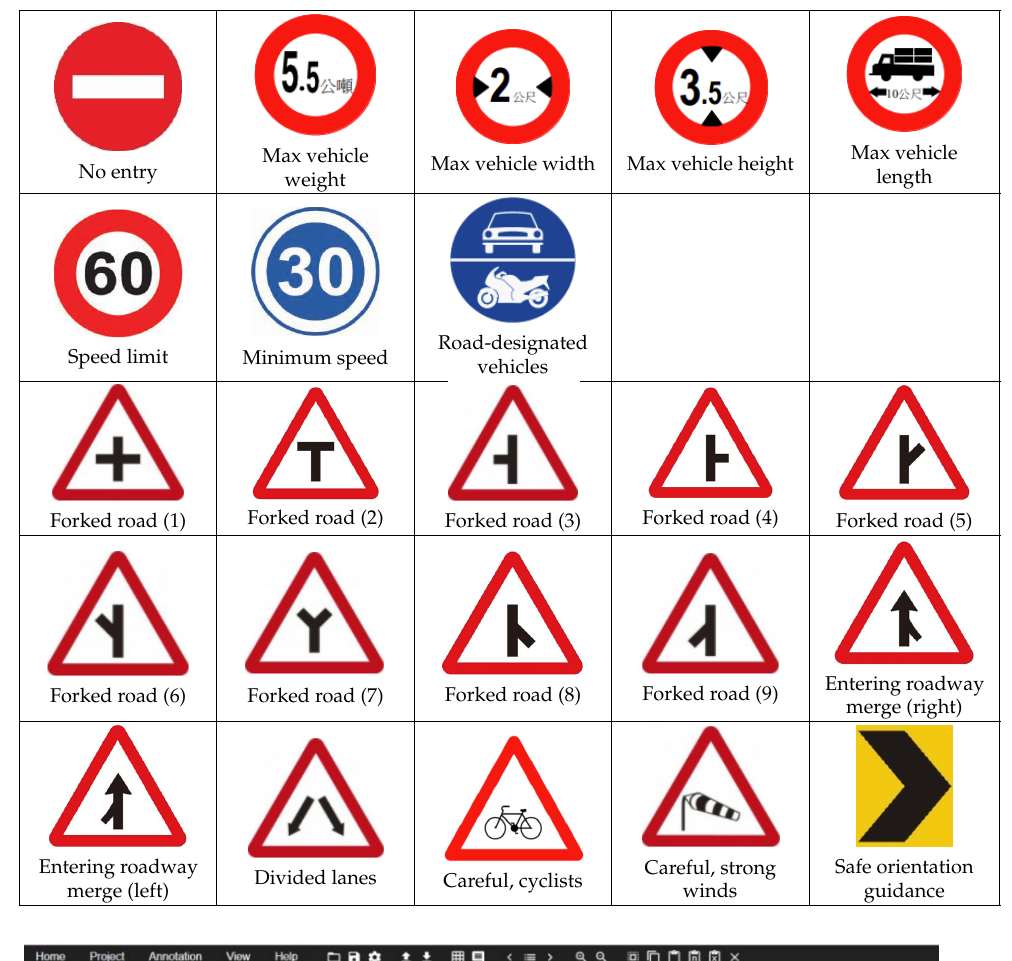
Table 1. Presentation of traffic signs in the created dataset (Chinese means metric ton and meter).